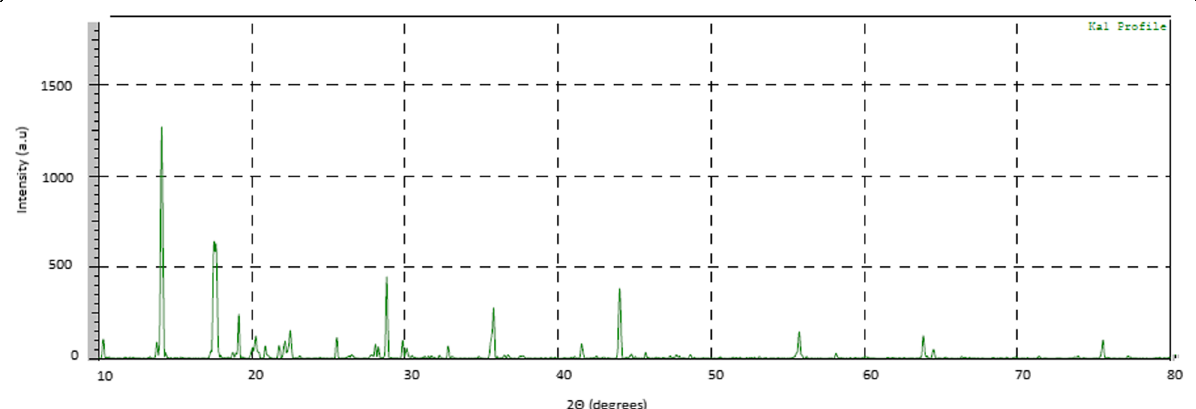
Fig. 7 XRD scan of crystals formed from 0.058 g/ml of solute in methanol obtained by solvent evaporation method carried out for 48 h with